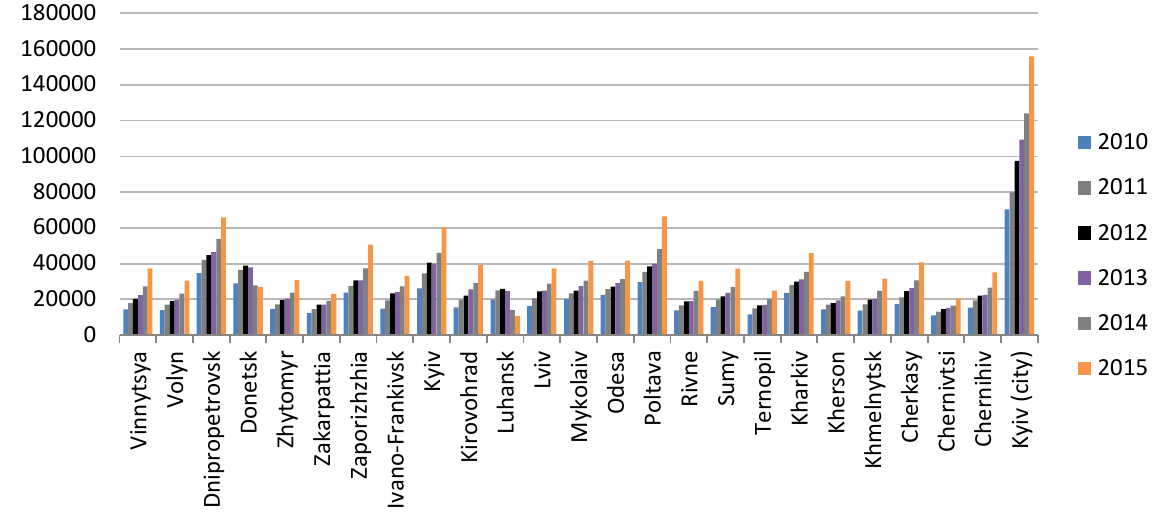
Fig. 3. The GRP per capita by region in 2010 – 2015, UAH million (based on data of the State Statistics Service of Ukraine)